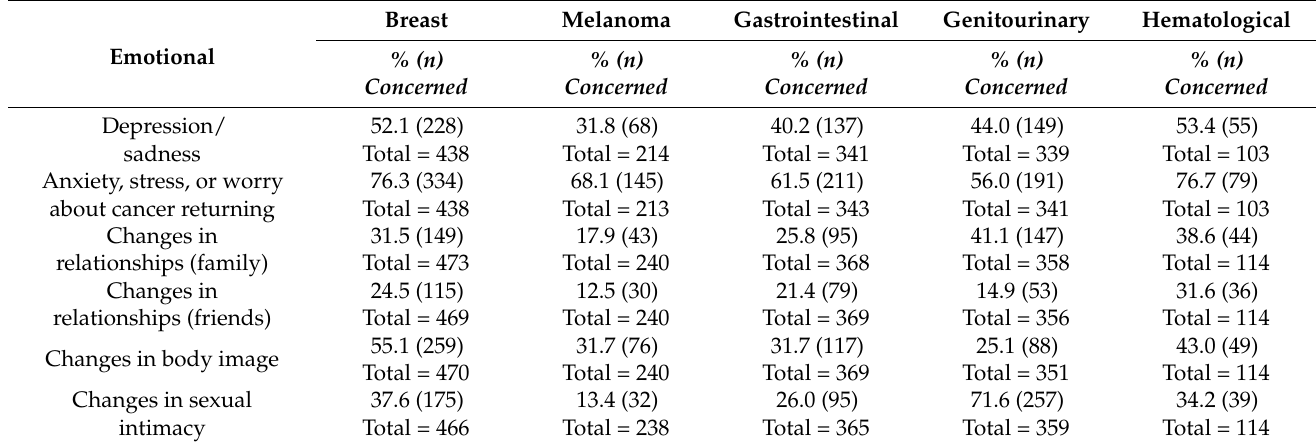
Table 4. Respondents’ concerns in the emotional domain (by tumour